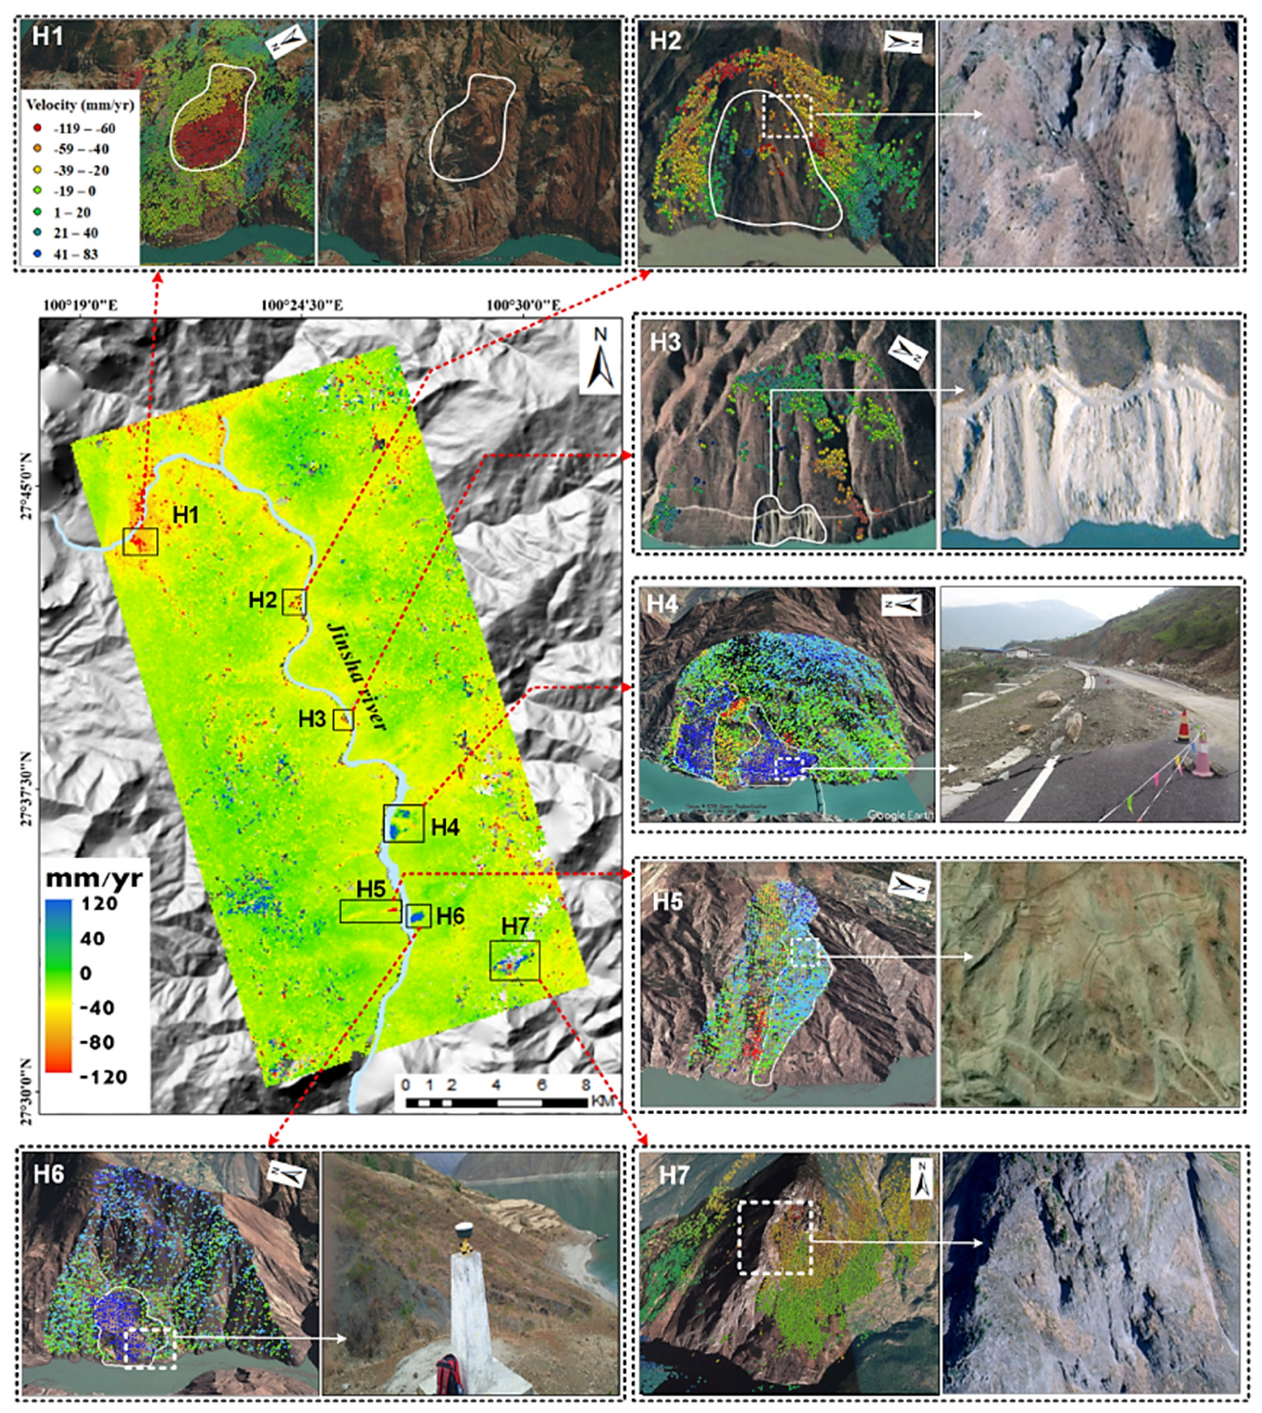
Figure 7. Deformation observed using ascending Sentinel-1A data and landslide identification results.